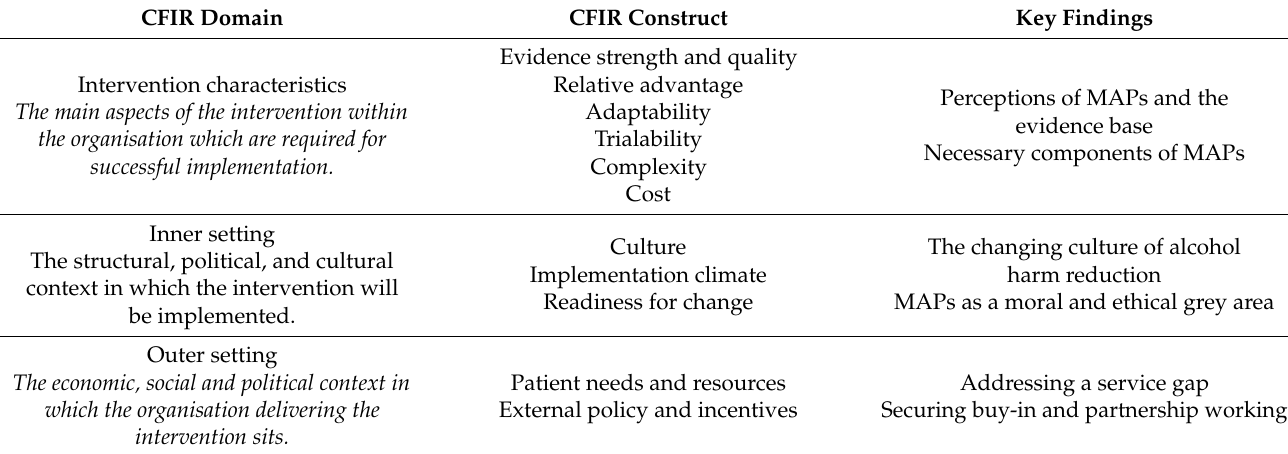
Table 2. Domains, constructs and key